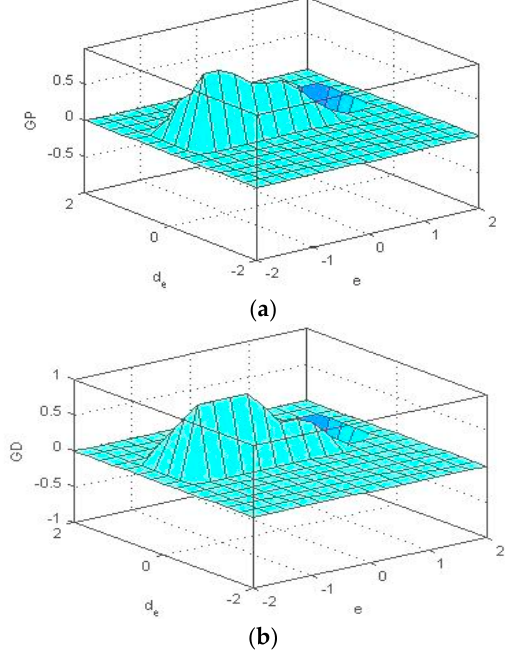
Figure 4. ( a ) The output surface of the fuzzy-based proportional controller; ( b ) the output surface of the fuzzy-based derivative controller.